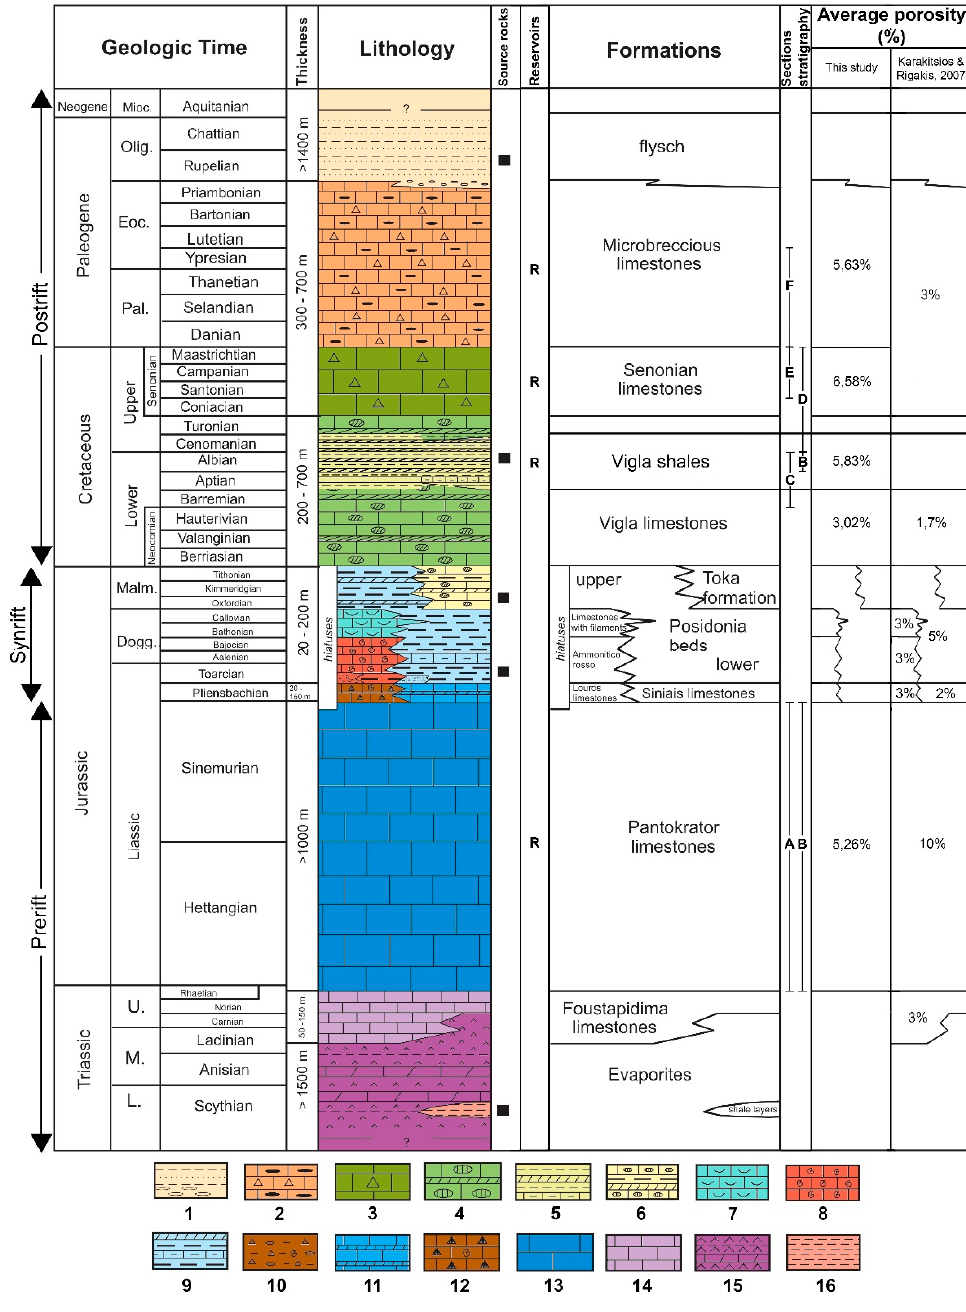
Figure 3. Synthetic lithostratigraphic column of the Ionian zone (modified from [34]), along with the correspondence of study sections stratigraphy with Ionian formations and their average porosity values as potential reservoir rocks. The colors in the lithostratigraphic column are consistent with the relevant colors of the International Chronostratigraphic Chart (v2020/01). (1) Shales and sandstones; (2) limestones with rare cherty intercalations, occasionally microbreccious; (3) pelagic limestones with clastic platform elements; (4) pelagic limestones with cherts; (5) cherty beds with shale and marl intercalations; (6) pelagic limestones with cherty nodules and marls; (7) pelagic limestones with bivalves; (8) pelagic, nodular red limestones with ammonites; (9) marly limestones and laminated marls; (10) conglomerates-breccias and marls with ammonites; (11) pelagic limestones with rare cherty intercalations; (12) external platform limestones with brachiopods and small ammonites in upper part; (13) platform limestones; (14) thin-bedded black limestones; (15) evaporites; (16) shales.